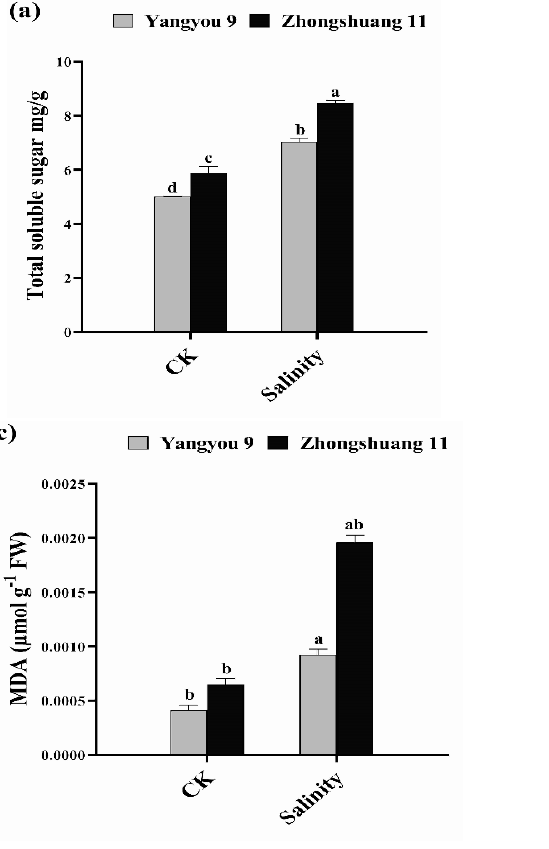
Figure 3. Modifications in ( a ) total soluble sugar, ( b ) total soluble protein, ( c ) MDA, and ( d ) proline content under normal and salt conditions induced by 150 mM NaCl. Bars represent ±SE of three replicates. Letters (a, b, c and d) on vertical bars represent significant differences between cultivars and treatments according to Duncan’s multiple range test (DMRT) at p < 0.05.